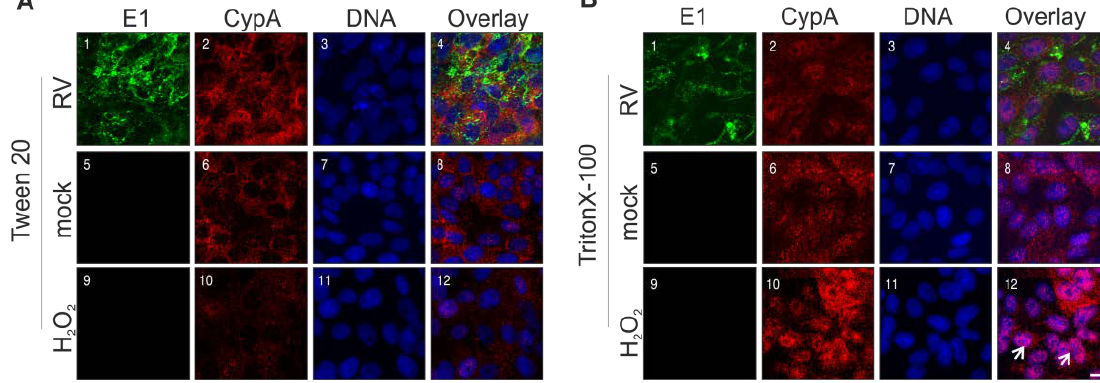
Figure 7. Impact of RV infection on intracellular distribution of cyclophilin A. Immunofluorescence analysis was performed with anti-CypA antibody (shown in red) and anti-E1 antibody (shown in green) for RV- and mock-infected Vero cells (3 dpi). Nuclear DNA is shown in blue. Pink colour indicates overlap areas. As a control, overnight incubation with 0.003% hydrogen peroxide (H 2 O 2 ) was included. After fixation with 2% ( w / v ) paraformealdehyde, cells were permeabilized with 0.1% TritonX-100 ( A ) or with 0.3% Tween 20 ( B ). Arrows point to representative cells with a clear shift of CypA to the nucleus. Scale bar, 10 μm.